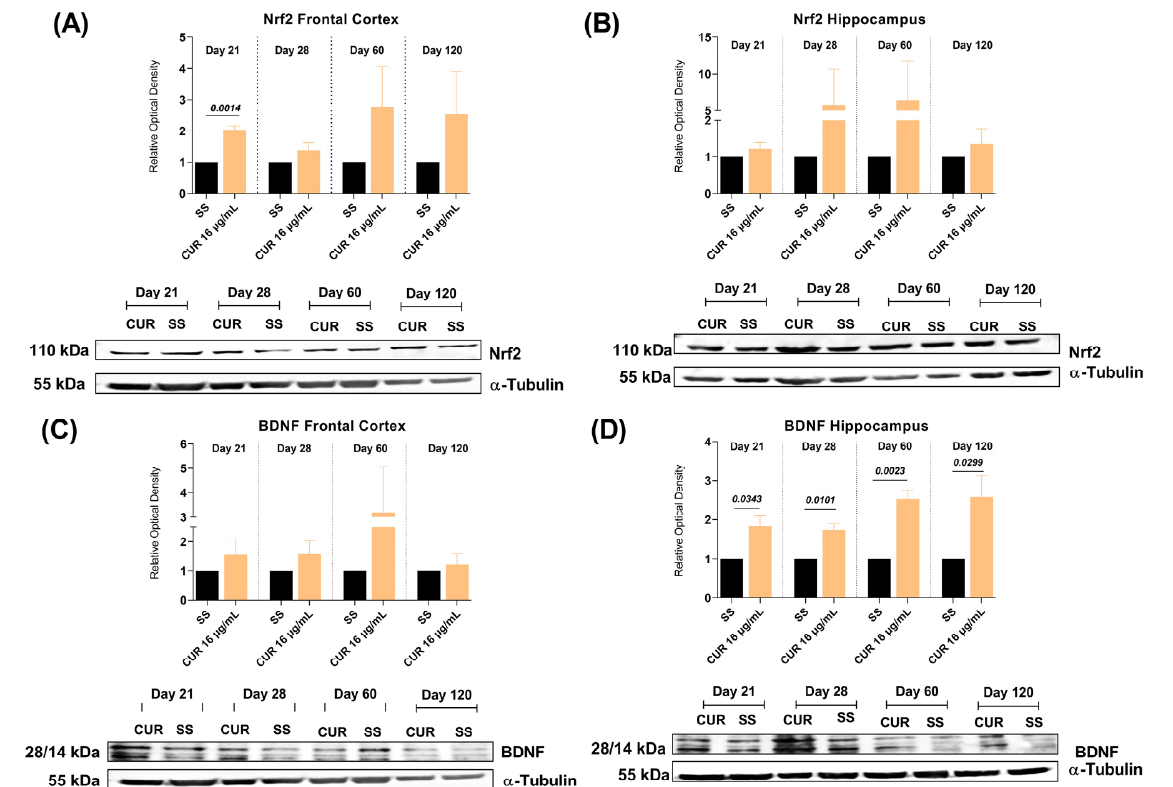
Figure 9. Effect of curcumin (CUR) treatment (16 μ g/mL) on the Nrf2 and BDNF levels in the frontal cortex and hippocampus of mice infected with Mtb H37Rv and control mice that just received the saline solution (SS) as the vehicle. ( A ) Quantification of the relative optical density of Nrf2 in the frontal cortex. Day 21, t = 11.55, df = 3. Unpaired t -test. The lower panel shows a representative image of the western blot at 21, 28, 60, and 120-days post-infection. ( B ) Quantification of the relative optical density of Nrf2 in the hippocampus. Unpaired t -test. The lower panel shows a representative image of the western blot at 21, 28, 60 and 120-days post-infection. ( C ) Quantification of the relative optical density of BDNF in the frontal cortex. Unpaired t -test. The lower panel shows a representative image of the western blot at 21, 28, 60 and 120-days post-infection. ( D ) Quantification of the relative optical density of BDNF in the hippocampus. Day 21, t = 3.157, df = 4. Unpaired t -test. Day 28, t = 4.587, df = 4. Unpaired t -test. Day 60, t = 6.945, df = 4. Unpaired t -test. Day 120, t = 6.166, df = 6. Unpaired t -test. The lower panel shows a representative image of the western blot at 21, 28, 60 and 120-days post-infection. Data are presented as mean ± SEM ( n = 6/day/group). The treatment with CUR increased Nrf2 levels in the frontal cortex, importantly at day 21 post-infection, showed an increasing trend at day 60 and 120 post-infection, and slightly increased Nrf2 levels in the hippocampus from day 21 post-infection. The treatment with CUR slightly increased BDNF levels in the frontal cortex from day 21 post-infection and, importantly, increased BDNF levels in the hippocampus at days 21, 28, 60 and 120